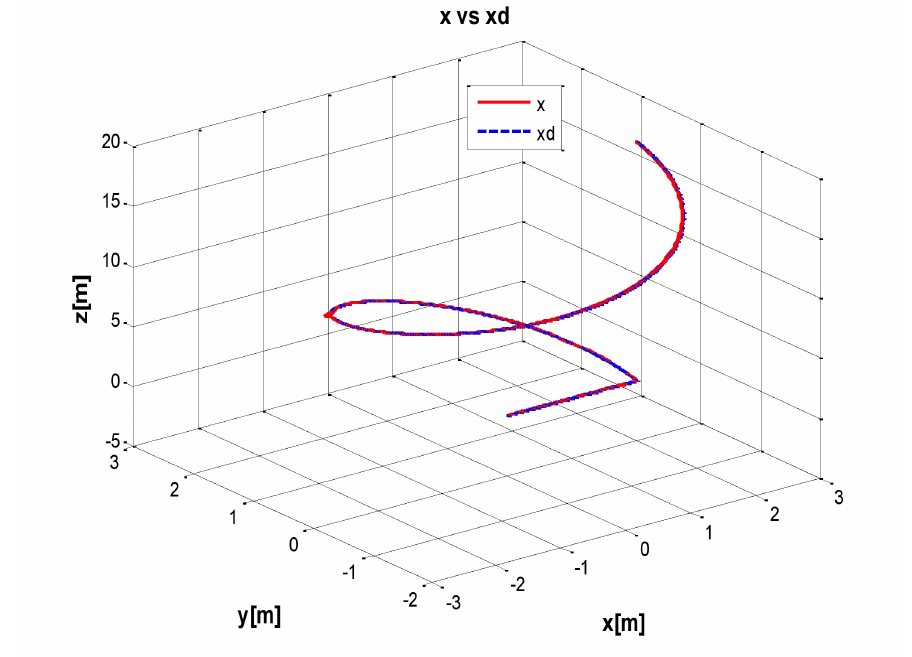
Figure 4. Real trajectory ( X Solid line) vs. desired trajectory ( X d dotted line), with